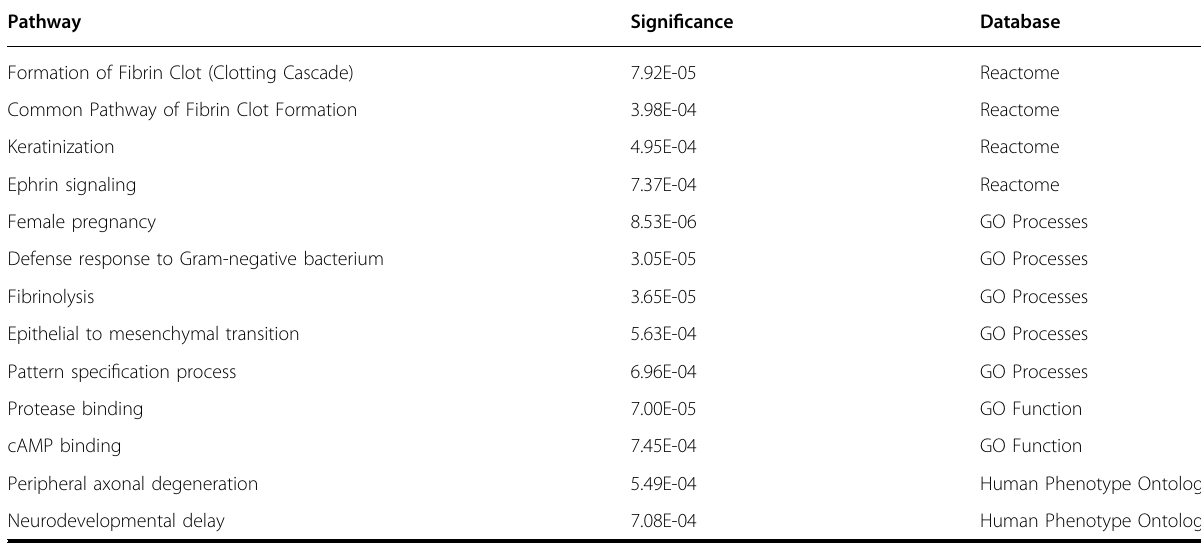
Table 2 Signi fi cant pathways of TWAS genes identi fi ed through gene-network analysis.